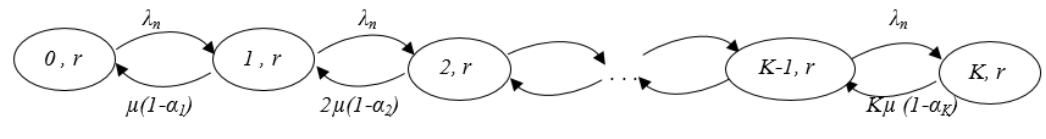
Figure 3. Graph of the splitting model with state space E r n , r = 0, 1, ... , R −